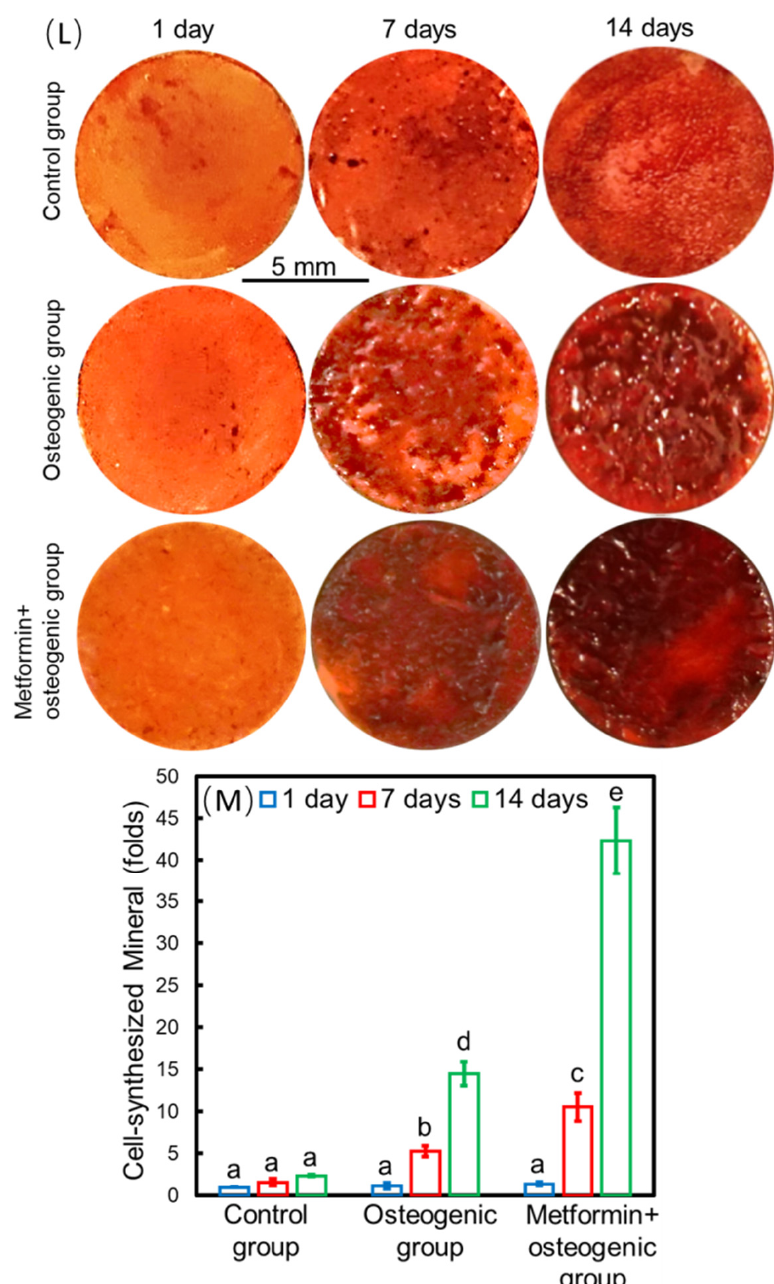
Figure 2. Methods of seed-cell drug delivery via a calcium phosphate cement (CPCs)/alginate-hydrogel-microfiber (MF) scaffold system. Live/dead staining images of cells seeding on the CPC-MF scaffold system at days 1, 7, and 14 ( A – I ); live cell density and percentages of live cells encapsulated in CPC-MF scaffold system ( J , K ); synthesis of bone minerals by the encapsulated stem cells, which was enhanced by the encapsulated metformin. Alizarin red (ARS) staining and cell-synthesized mineral quantification of human periodontal ligament cells (hPDLSCs) on CPC-MF scaffold system with or without metformin ( L , M ) Values with dissimilar letters (a,b,c) are significantly different from each other ( p < 0.05). (Adapted from reference [9], with permission).